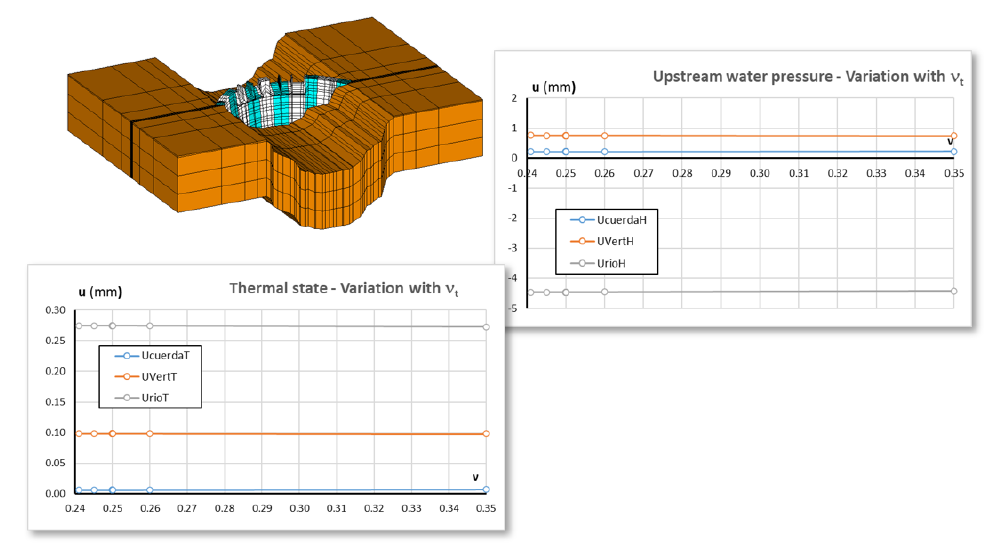
Figure 5. Study of the sensitivity of dam movement to changes in the Poisson ratio.